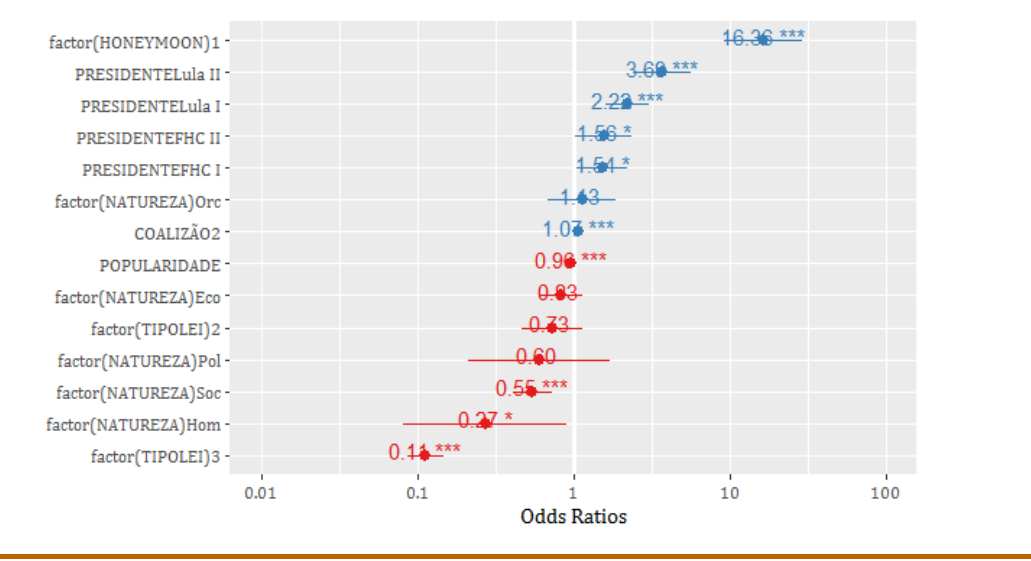
Source: Elaborated by the